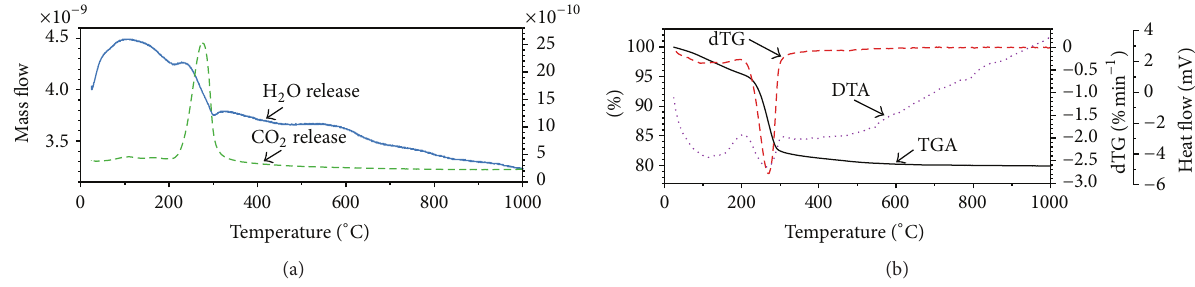
Figure 2: Thermogravimetric analysis of cerium carbonate (b) with mass-spectroscopic detection of released gases